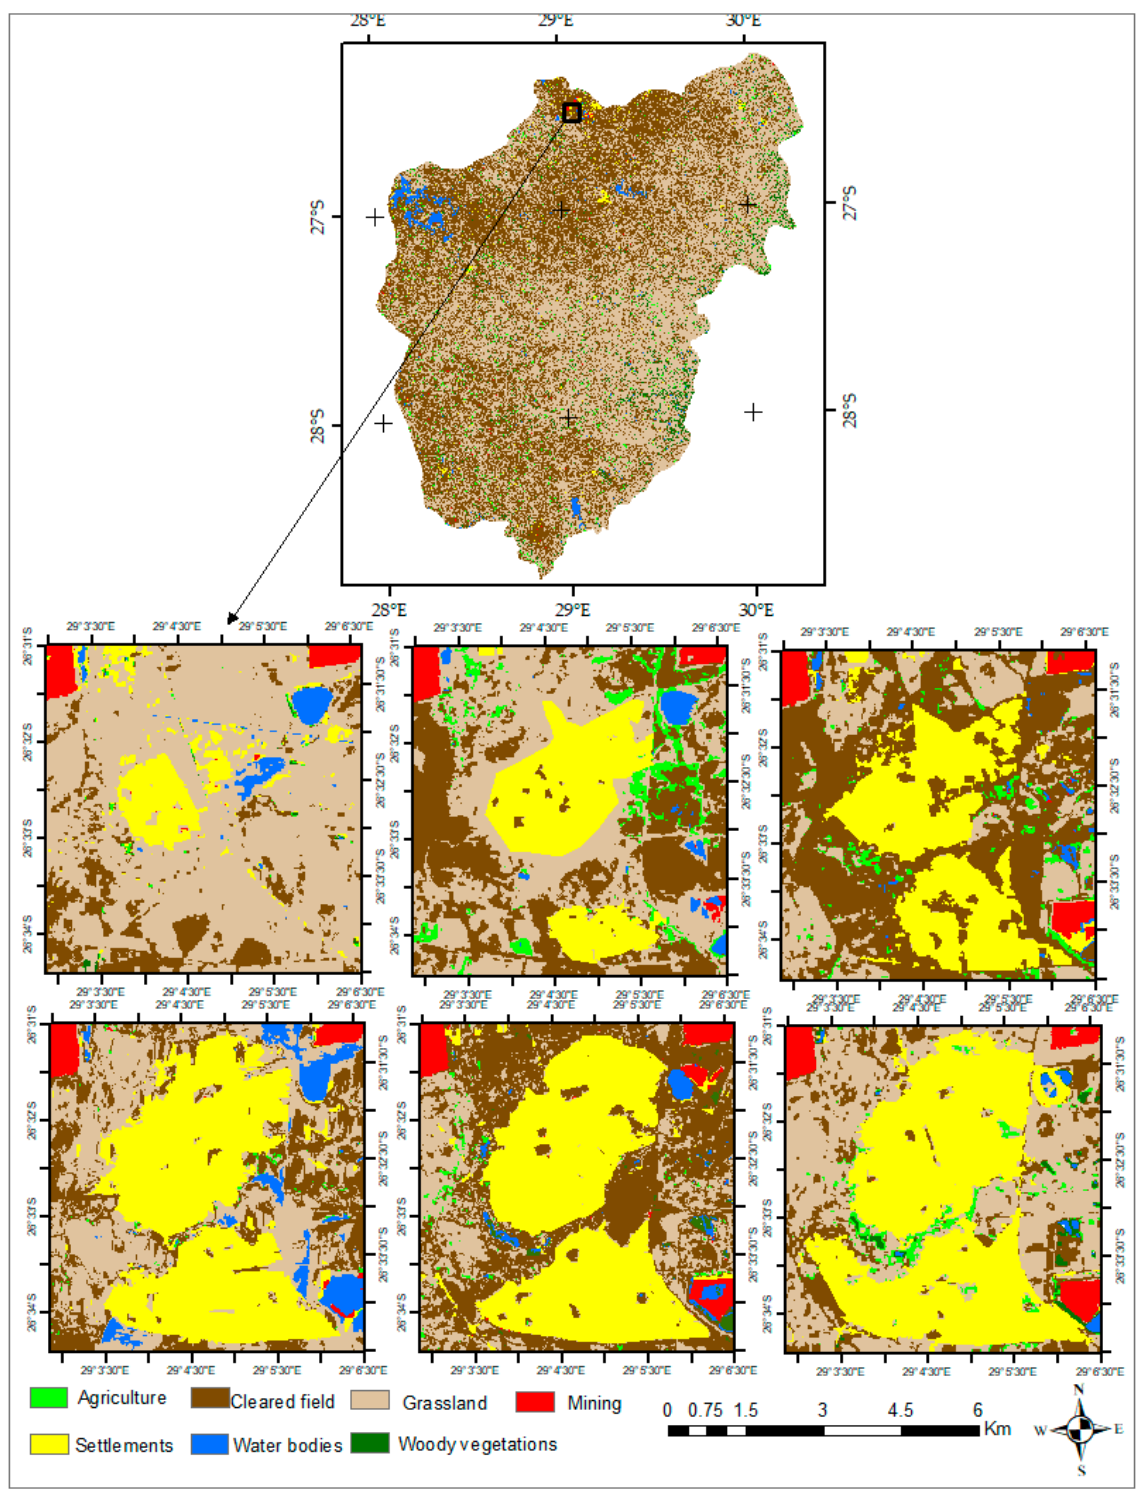
Figure 5. A sample of settlement expansion for eMbalenhle township in the northern part of the Vaal Dam Catchment during the period 1986–2021.